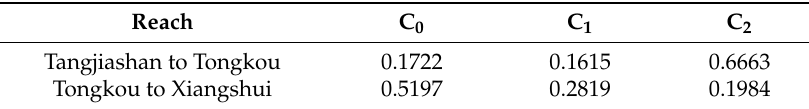
Table 4. Muskingum parameters.